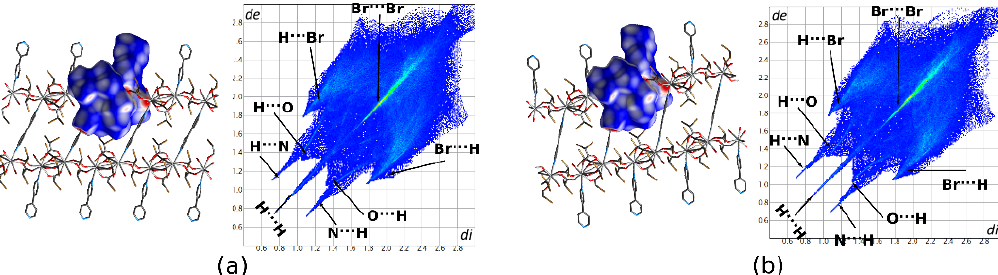
Figure 9. Hirshfeld Surfaces and 2D Fingerprint Plots (FPs) generated for the asymmetric unit of 1 ( a ) and 2 ( b ). Over the HS d norm is mapped. d norm is visualized over a fixed color scale of −1 .12 (red), 0.47 (white), to 1.46 (blue). d e and d i are the distances to the nearest atomic exterior and interior to the surface.